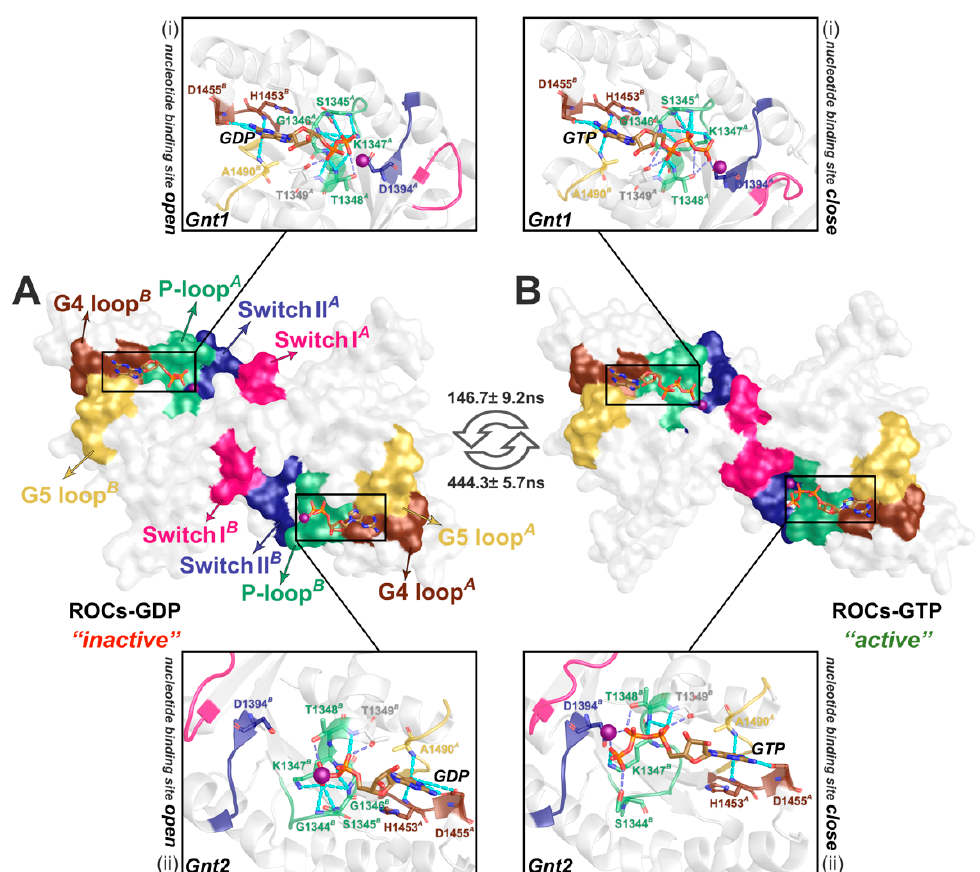
Figure 3. Detailed bonding network between the guanine nucleotide and ROCs in the representative structure from ( A ) ROCs-GDP, S3 GDP , and ( B ) ROCs-GTP, S2 GTP . The molecular surface diagram in the middle highlighted regions implicated in nucleotide binding, as color-coded in Figure 1B. The zoom-in graphs above (i) and below (ii) depicted the detailed interactions between ROCs and nucleotide Gnt1 and Gnt2 , respectively.